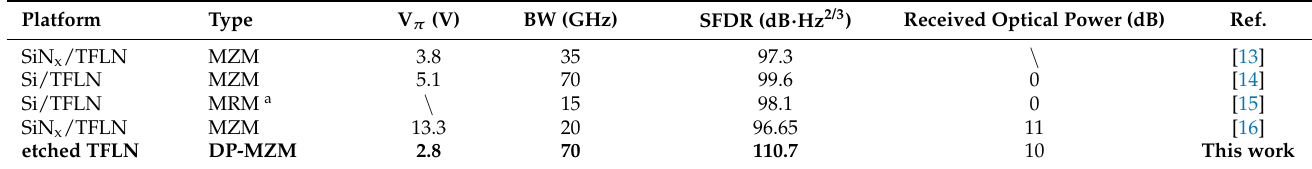
Table 1. Comparison of the reported modulators on TFLN